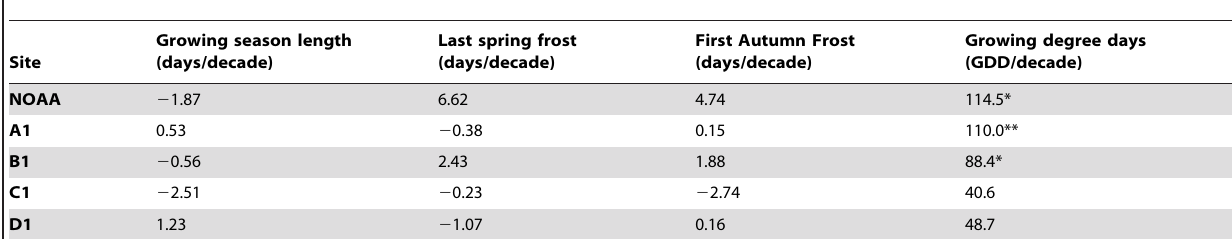
Rates of change (slopes) were derived from linear regression. **p ,